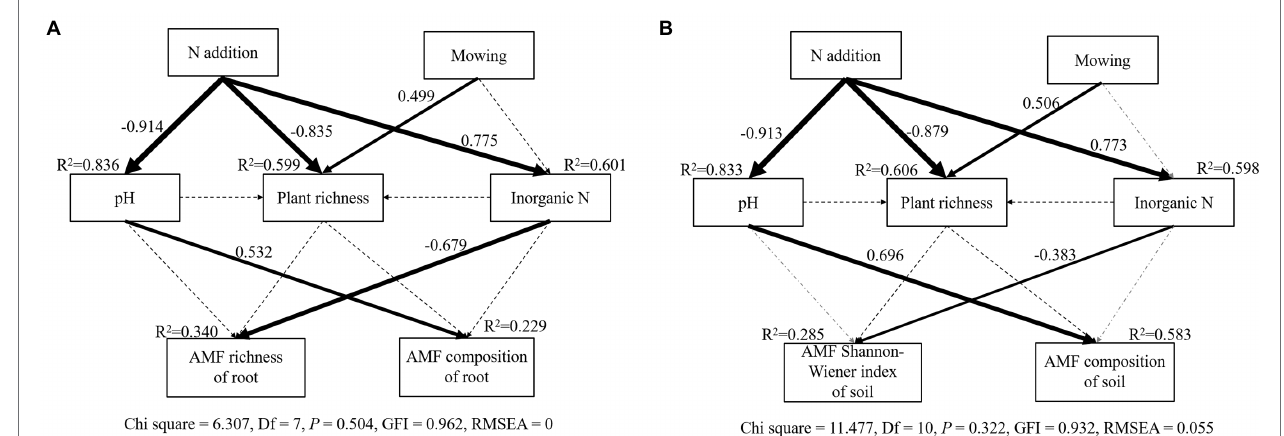
FIGURE 5 | The structural equation modeling (SEM) analysis of the effects of nitrogen addition and mowing on AM fungal richness, community composition in roots (A) and AM fungal community Shannon-Wiener index, community composition in soil (B) via the pathways of nitrogen addition, mowing, soil pH, soil inorganic N, plant richness. Numbers adjacent to arrows are path coefficients, and width of the arrows is proportional to the strength of path coefficients. Black dashed arrows indicate non-significant relationships ( p > 0.05). Gray dashed arrows indicate paths removed to improve model fits. Percentages close to endogenous variables indicate the variance explained by the model ( R 2 ).